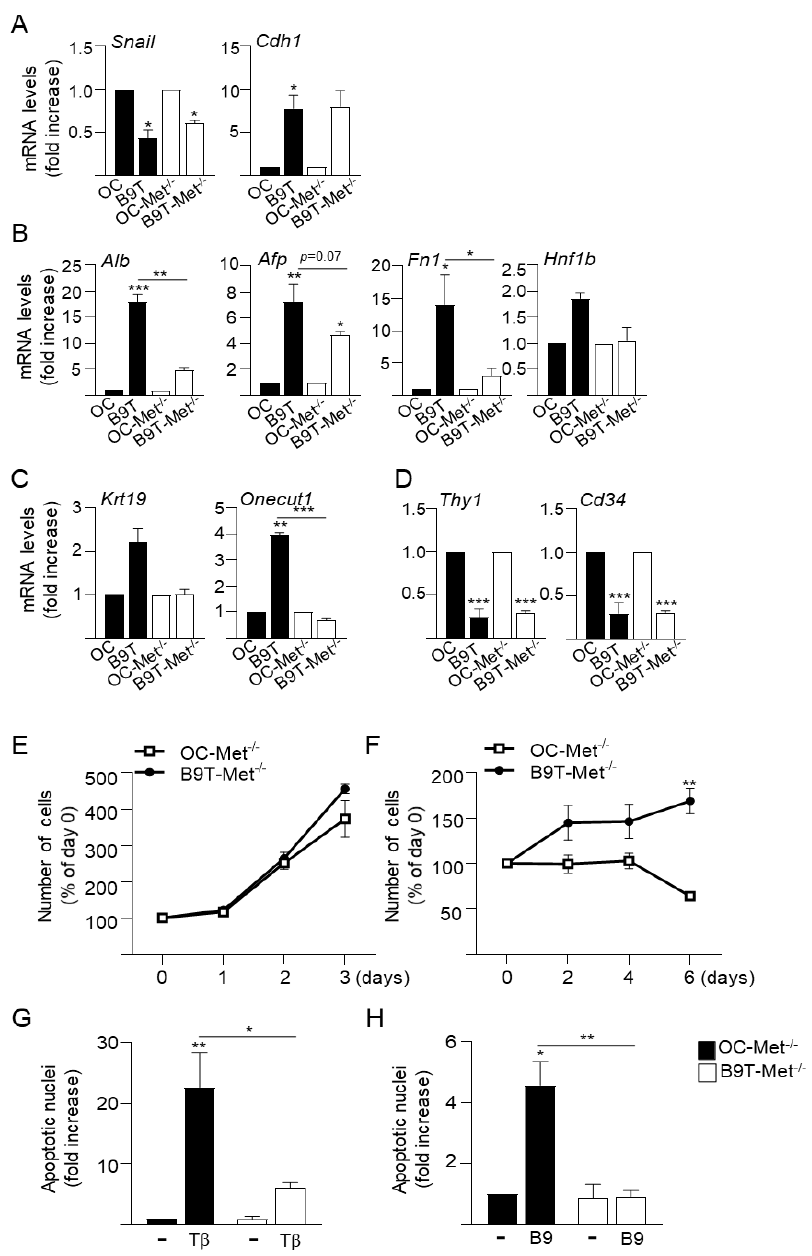
Figure 5. Analysis of the role of Met in the acquisition of B9T-OC properties. ( A – D ). RT-qPCR analysis for the expression of ( A ) EMT markers, ( B ) hepatocyte markers, ( C ) biliary cell markers and ( D ) hematopoietic stem/progenitor cell markers in OC, B9T-OC, OC-Met –/– and B9T-Met –/– . Gusb was used for normalization. Data are expressed relative to OC and OC-Met –/– (assigned an arbitrary value of 1) and are mean ± SEM of three independent experiments. ( E , F ). Met –/– oval cells (OC-Met –/– ) and B9T-OC-Met –/– cells (B9T-Met –/– ) were cultured in the presence ( E ) or absence ( F ) of 10% FBS for different periods of time and the number of cells was counted. Data are expressed with respect to parental OC-Met –/– (mean ± SEM) and are from three independent experiments performed in triplicate. Data were compared between cell lines. ( G , H ) Met –/– oval cells (OC-Met –/– ) and B9T-OC- Met –/– (B9T-Met –/– ) were serum-starved and incubated in the presence of ( G ) TGF- β (2 ng/mL) or ( H ) BMP9 (2 ng/mL) for 48 h. Apoptotic index was calculated by counting apoptotic nuclei after PI staining under a fluorescence microscope. A minimum of 1000 nuclei was counted per condition. Data from three independent experiments performed in triplicate (mean ± SEM) are shown. Data were compared with the untreated condition or as indicated, * p < 0.05, ** p < 0.01 and *** p <